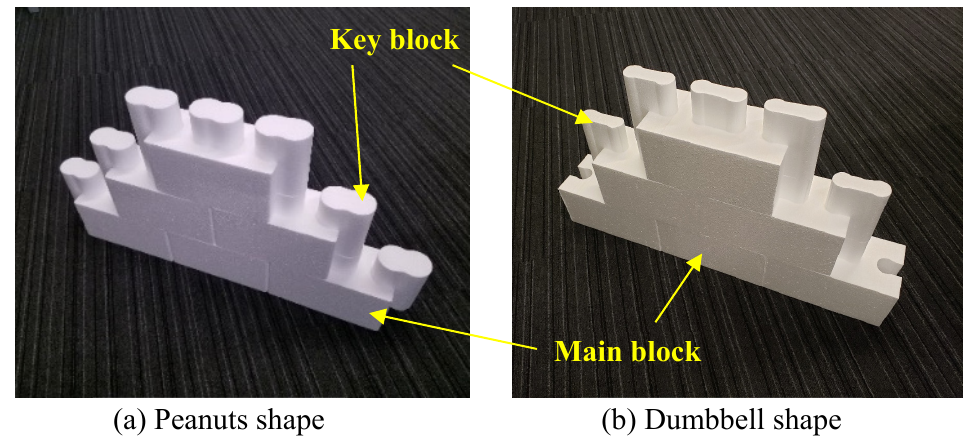
Figure 3. Construction of the proposed block walls.